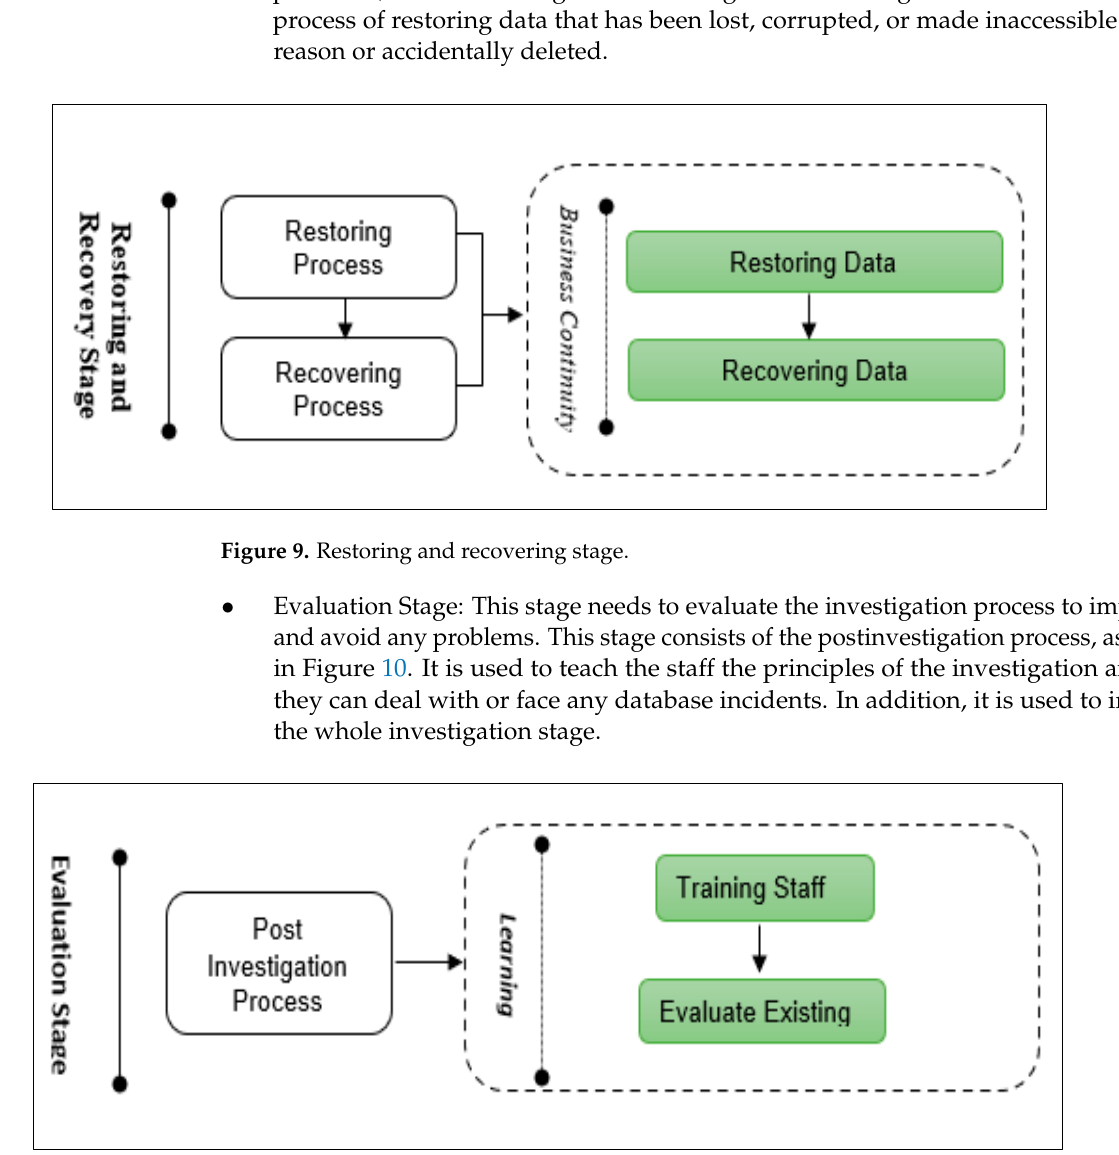
Figure 8. Investigation Stage.